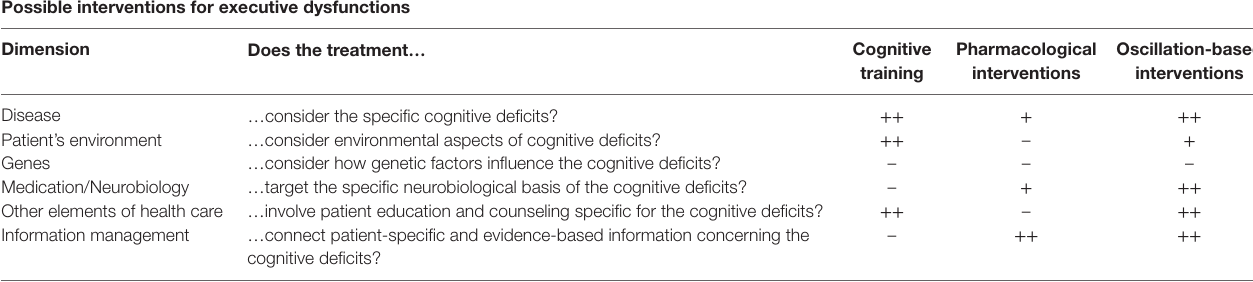
tABLe 1 | Comparison of cognitive (executive function) training, pharmacological interventions and oscillation-based interventions on different dimensions currently defining individualized/personalized medicine [adapted from Ref. (5)]. Possible interventions for executive dysfunctions